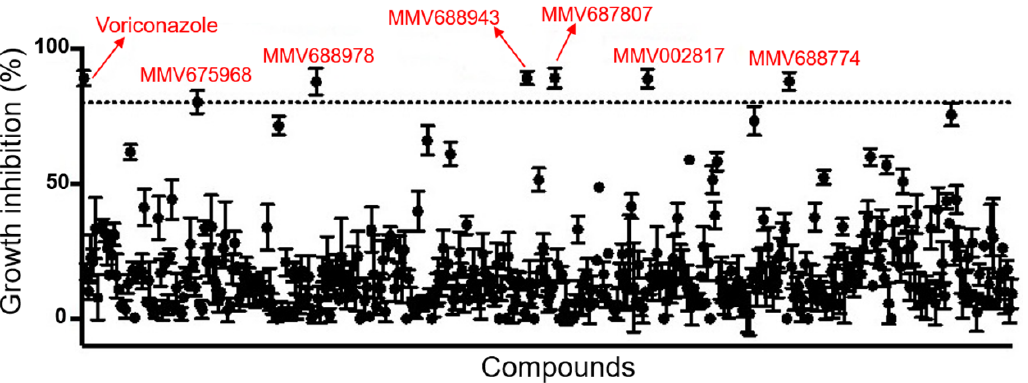
Figure 1. Screening of the Pathogen Box library. The total of 400 compounds were screened against S. aurantiacum CBS 136046. After incubation for 72 h, fungal growth was quantified by optical density and those presenting at least 80% of inhibition (dotted line) were selected. Voriconazole was used as a positive control of inhibition.